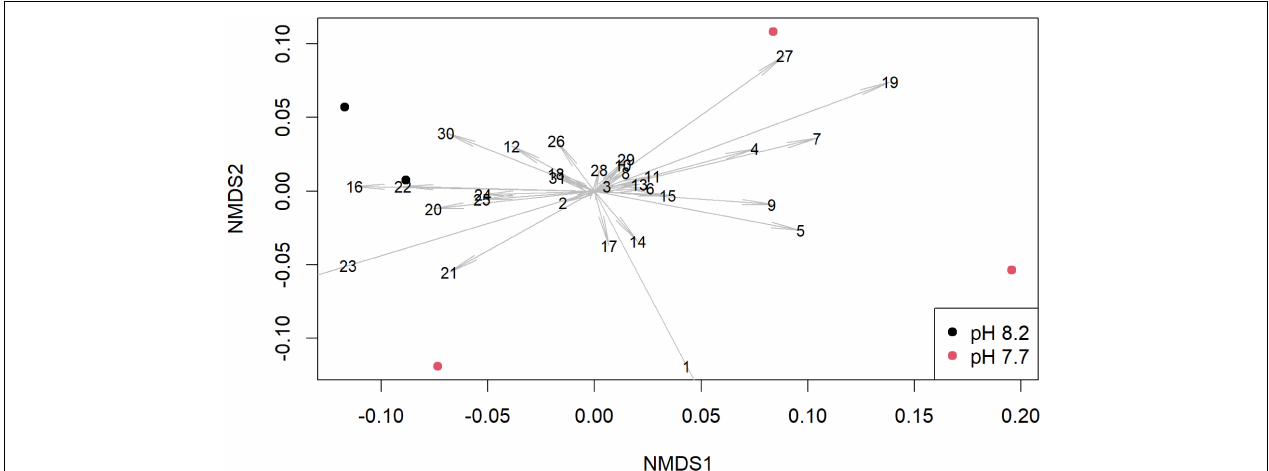
FIGURE 2 | Non-metric multidimensional scaling (NMDS) plot of the abundance of volatile organic compounds (VOCs) normalized to internal standard from Cocconeis scuteullum var. parva depending on culture pH level. Dots indicate independently replicate and separately analyzed cultures of the same algal isolate, distances between dots indicate Bray-Curtis dissimilarities, arrow lengths indicate the contribution of the respective peak to the dissimilarity, numbers indicate the peak-identities (see Supplementary Table 4 ).